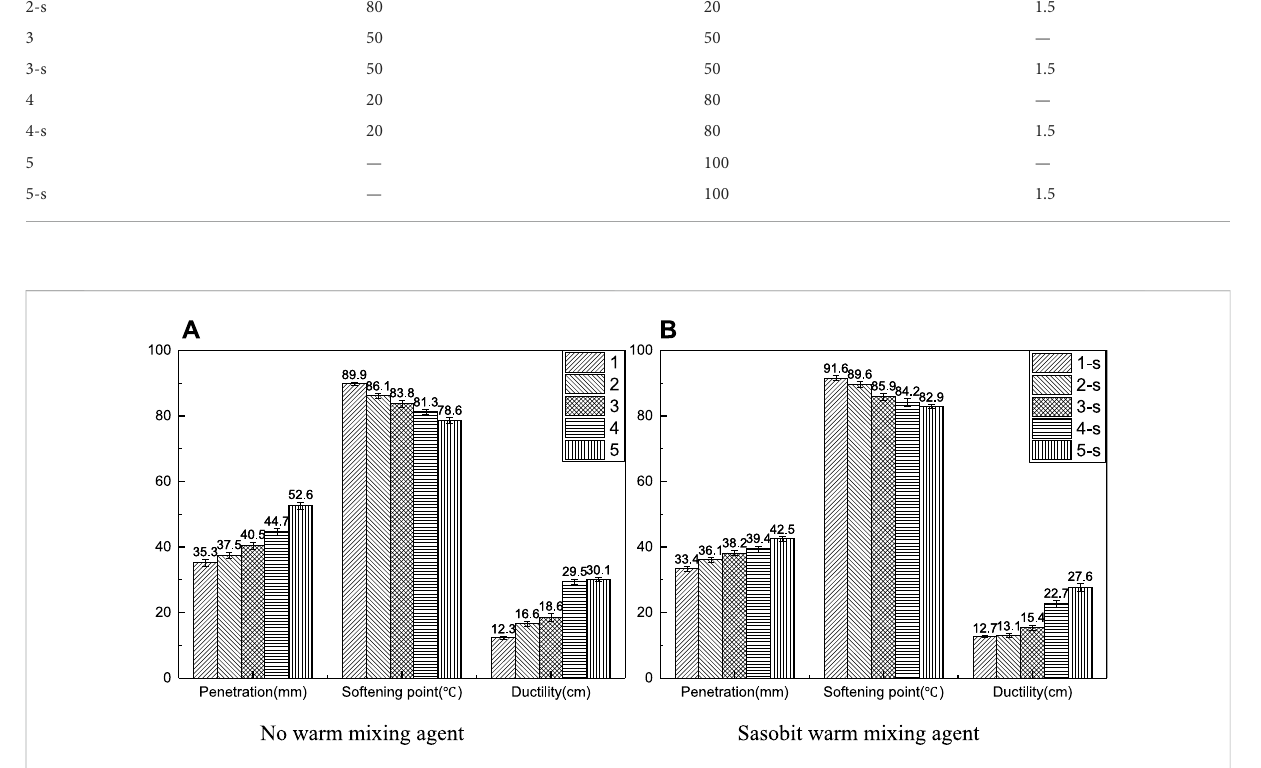
FIGURE 1 Penetration, softening point, and ductility for mixed asphalt samples (cf. Table 3 for